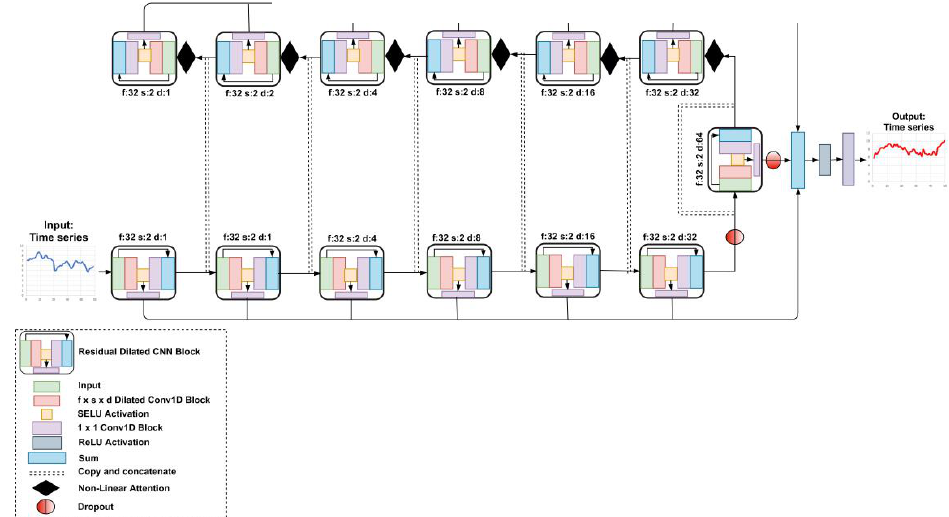
Figure 9. Residual attention U-Net with the proposed nonlinear attention block.